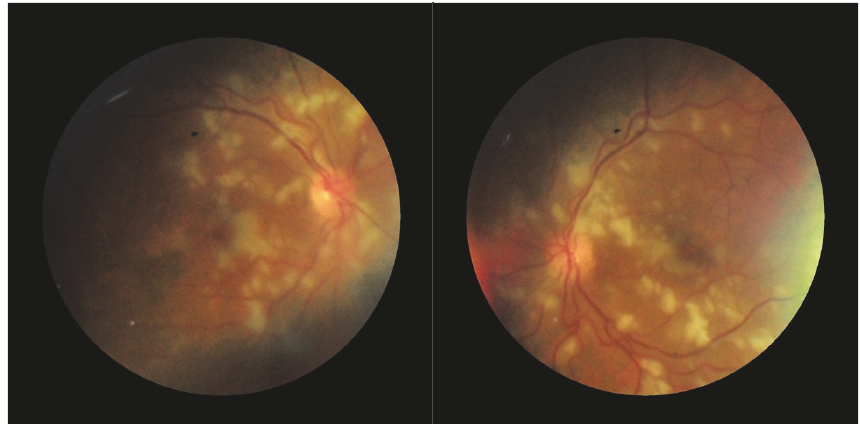
Figure 1: Right and left funduscopic images showing flame haemorrhages and cotton wool spots, consistent with grade 3 hypertensive retinopathy.